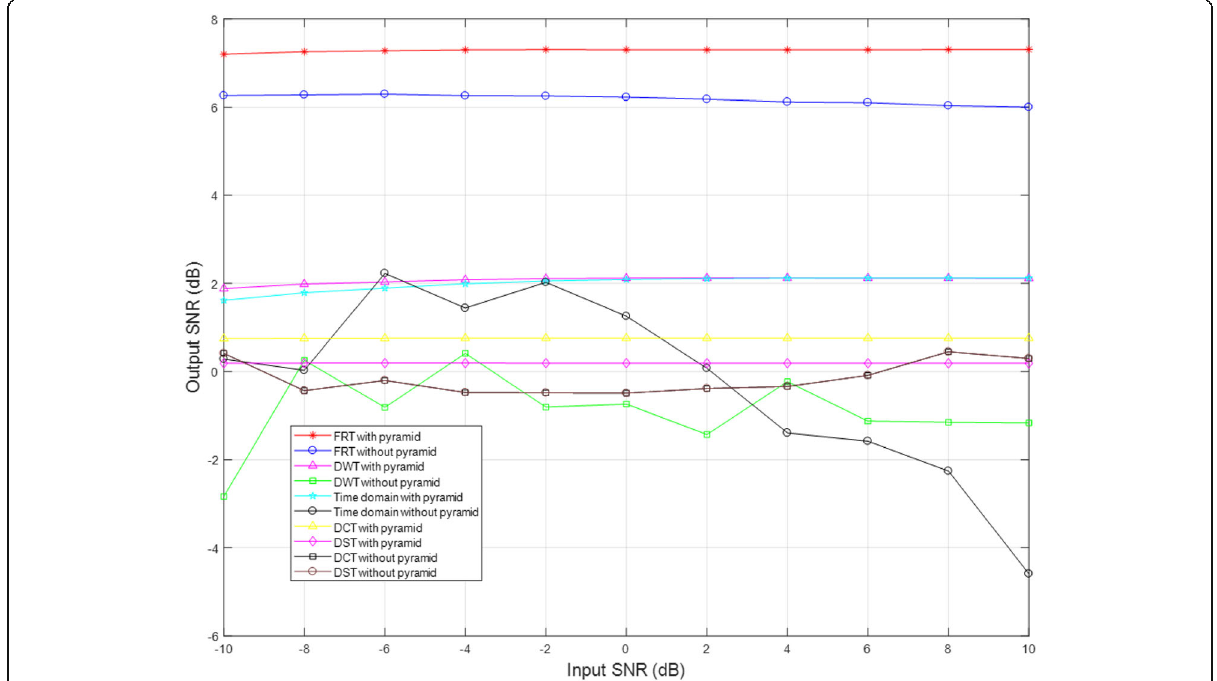
Fig. 11 Output SNR vs. input SNR for Cameraman image overall separation performances